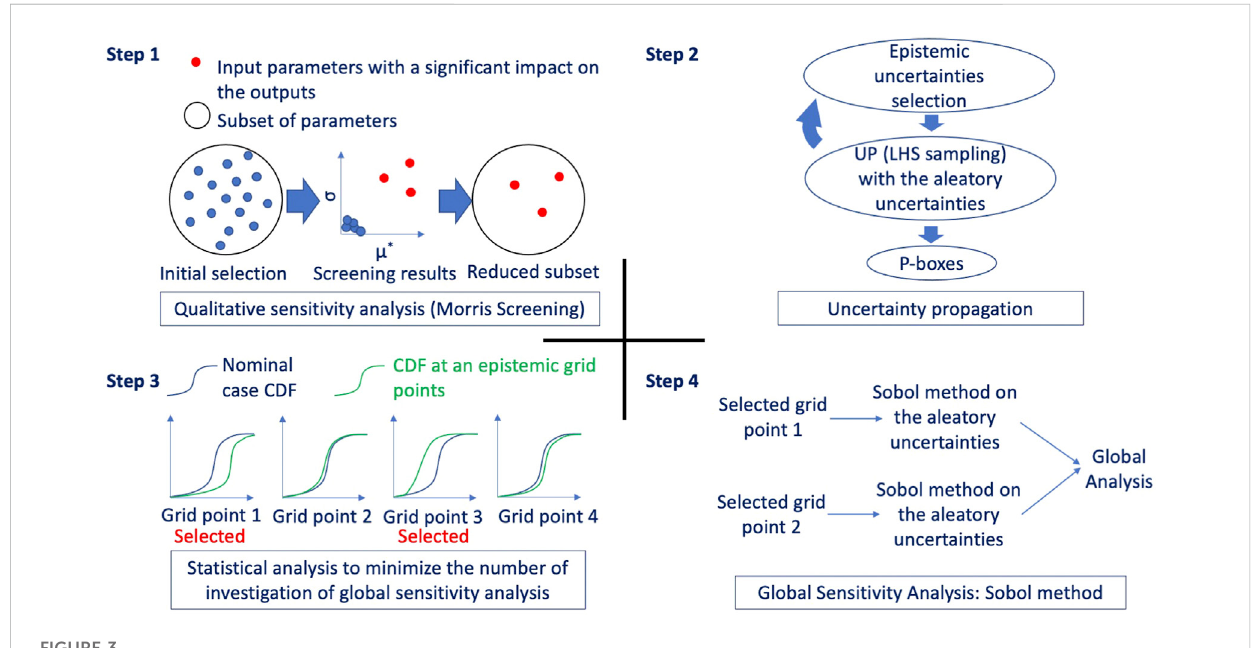
FIGURE 3 UQ and SA